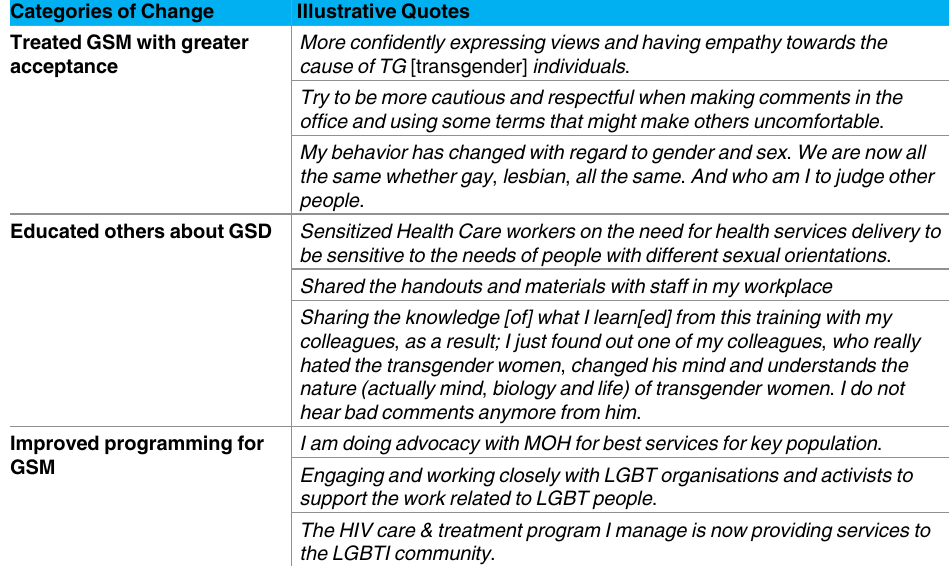
Table 7. Illustrative quotes of participant changes after gsd